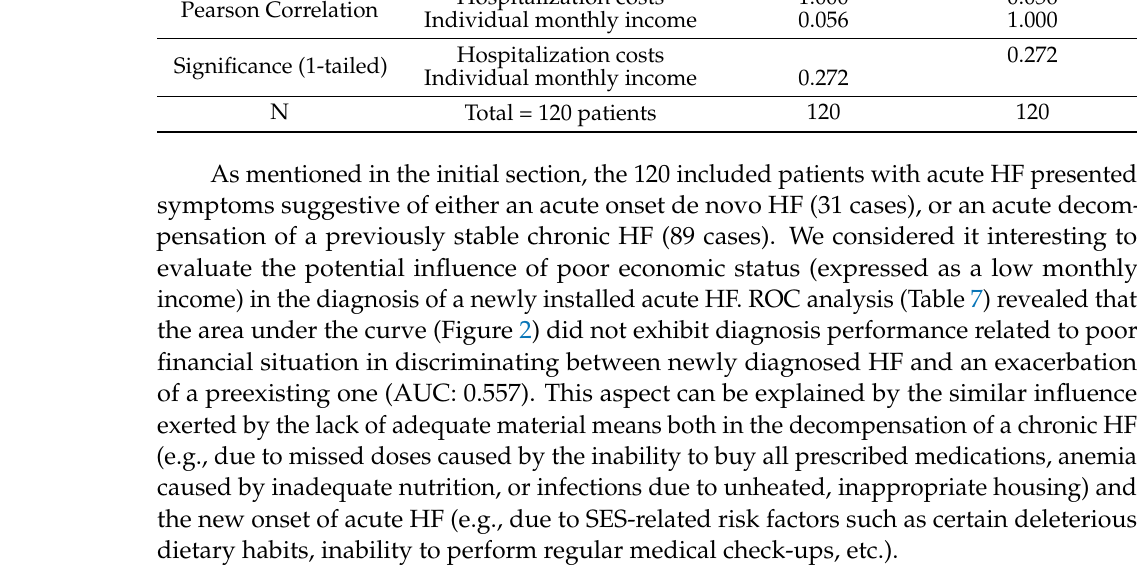
Table 7. AUC detailed analysis: income levels’ capacity in diagnosing newly installed